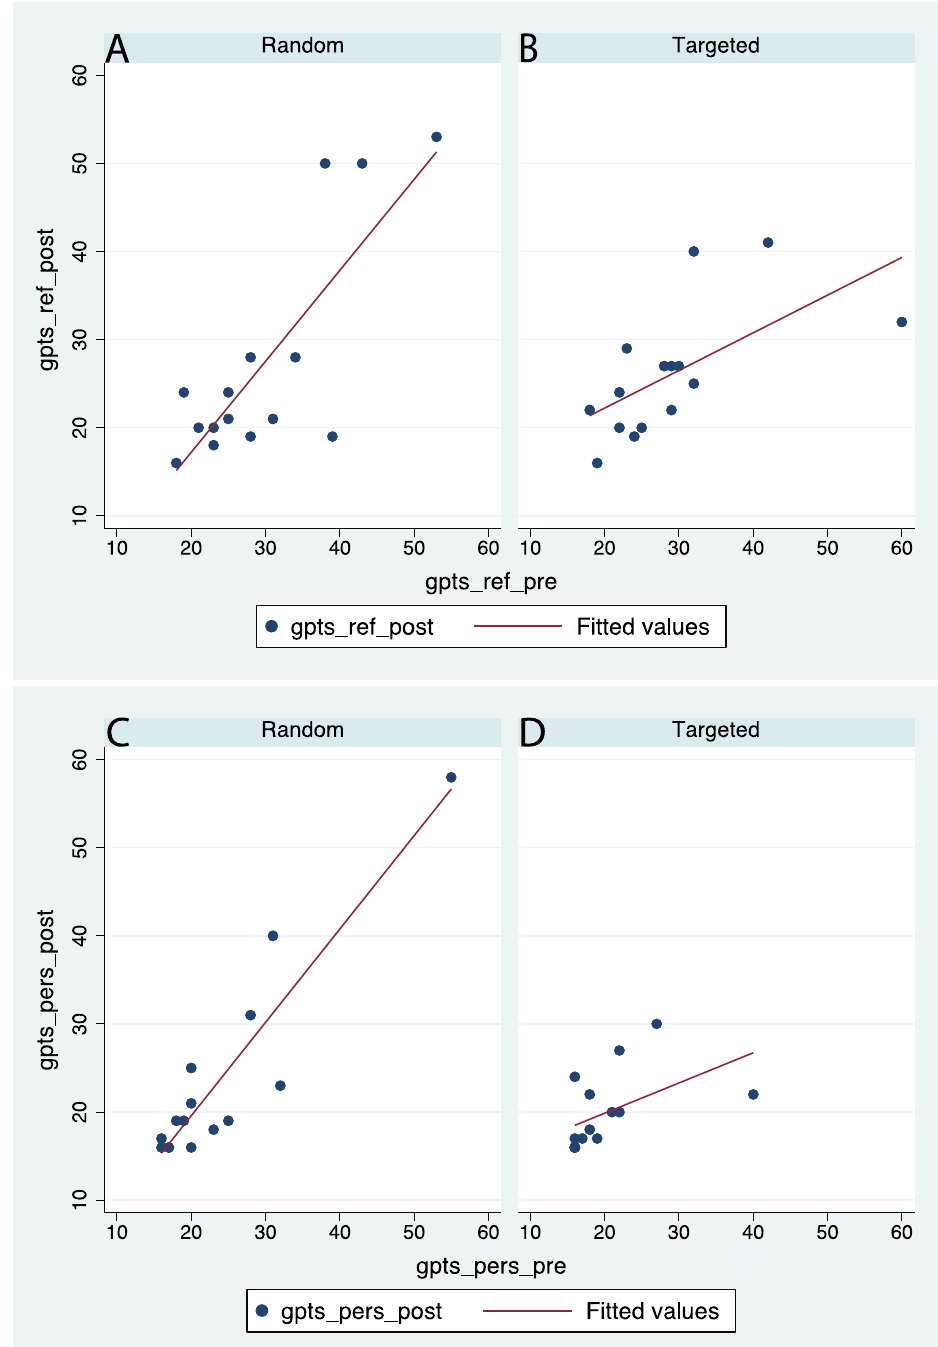
Figure 3. Scatter diagrams and regression lines of the post GPTS scores by the pre GPTS scores, by condition (Random, Targeted). ( A , B ) GPTS reference. ( C , D ) GPTS